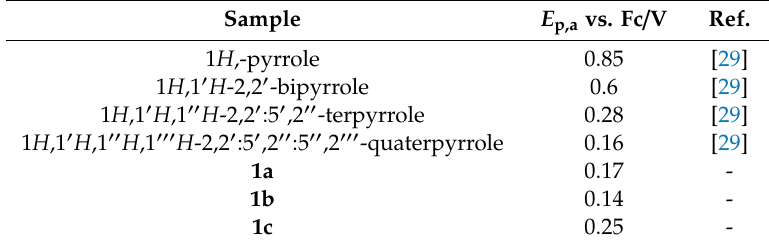
Table 1. Oxidation potential peaks (E)Pa against reference electrode and against Ferrocene for the 2,2 (cid:48) -bipyrrole monomers determined with the first cycles of electropolymerization.